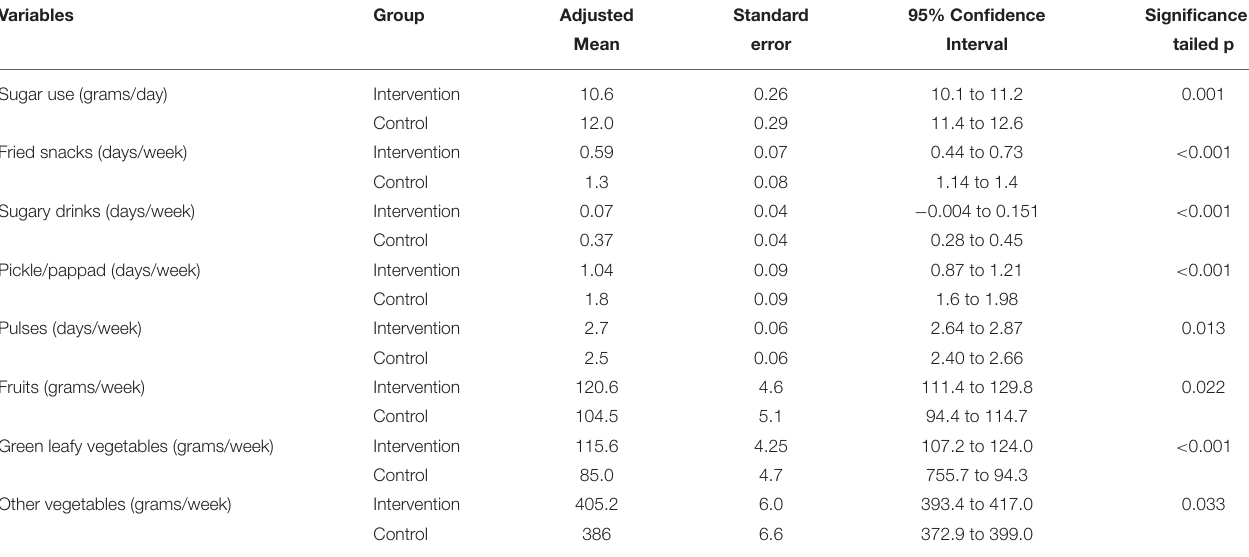
TABLE 4 | Dietary habits at end of follow-up adjusting for the baseline